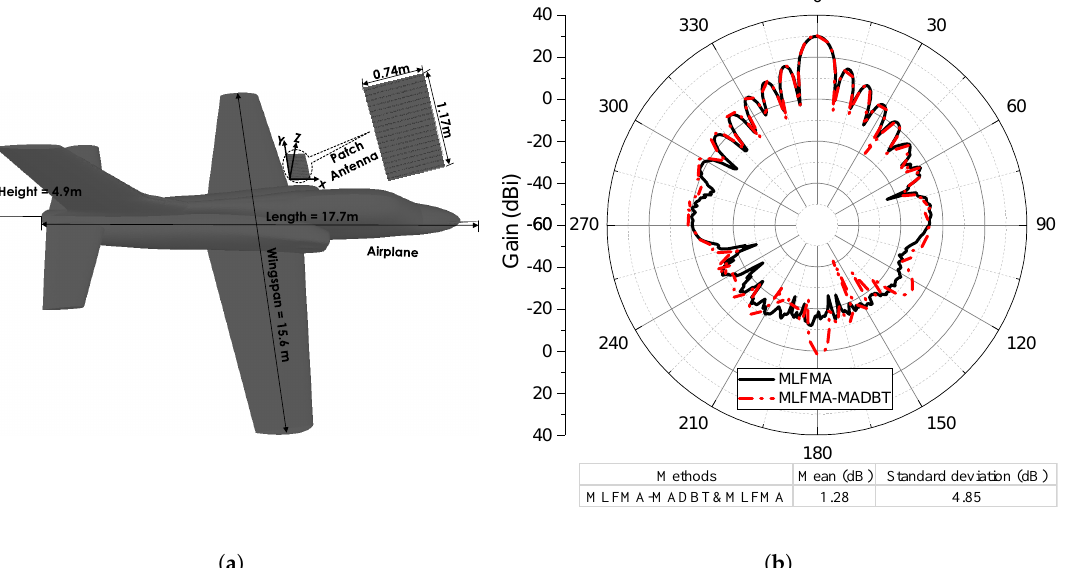
Figure 9. The model and far-field radiation patterns in XOZ plane of the patch antenna array installed above the top of an airplane. ( a ) Model ( b ) Comparison